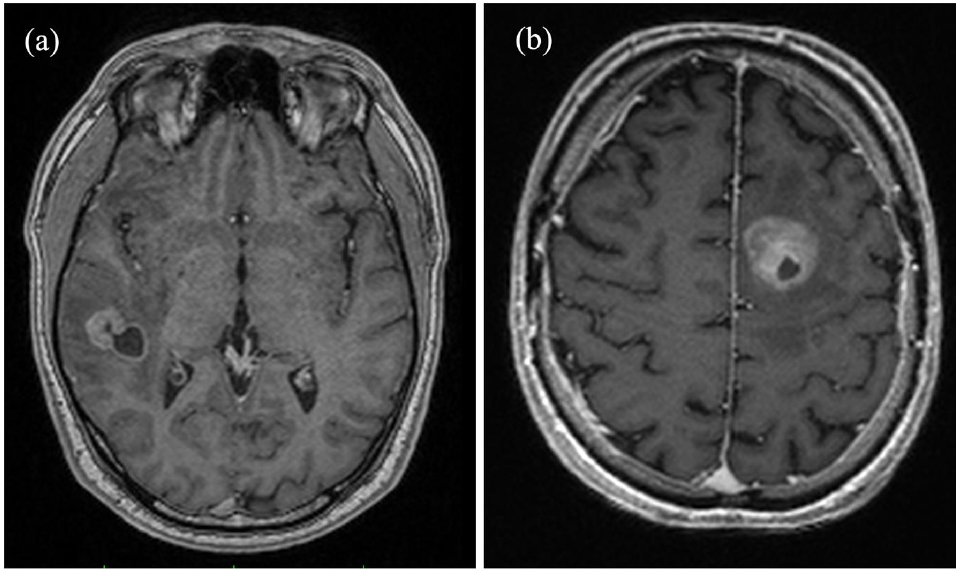
Figure 1. Axial contrast-enhanced magnetization prepared rapid gradient echo (MP-RAGE) brain images comparing ( a ) a right temporal metastasis from known esophageal cancer in a 50-year-old male patient and ( b ) a glioblastoma in the frontal lobe of the left hemisphere of a 71-year-old male patient. Both tumors show cystic elements and peripheral contrast enhancement, complicating a differentiation based on solely morphological criteria.